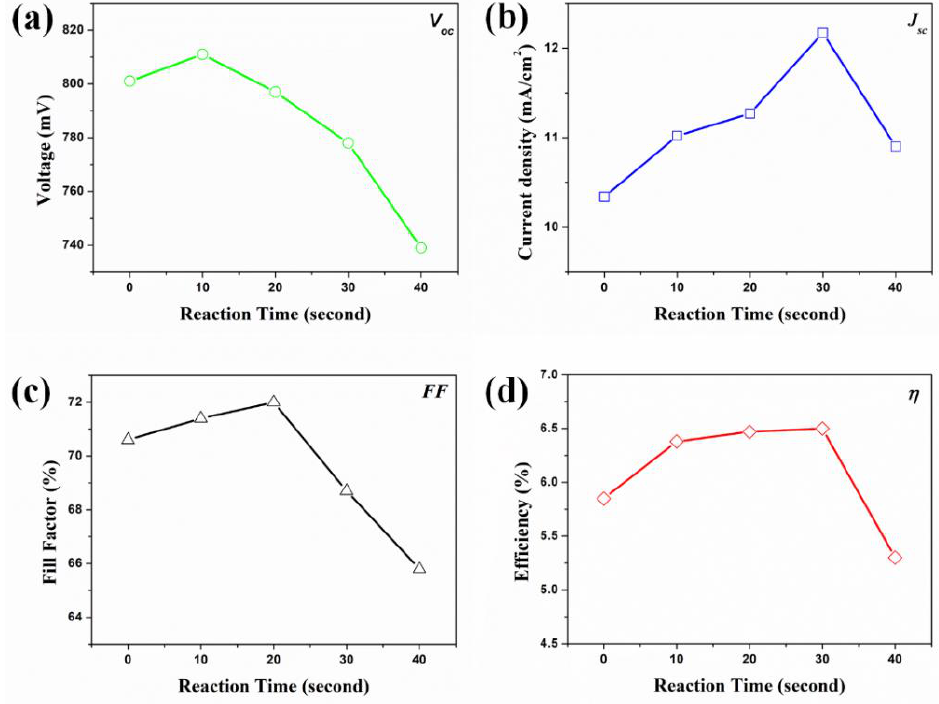
Figure 5. Photovoltaic properties of DSSCs based on the f-TNTAs with Au NPs: ( a ) voltage, ( b ) current density, ( c ) fill factor, and ( d ) efficiency. Table 1. Photovoltaic properties of DSSCs based on f-TNTAs with Au NPs. DSSCs Based on